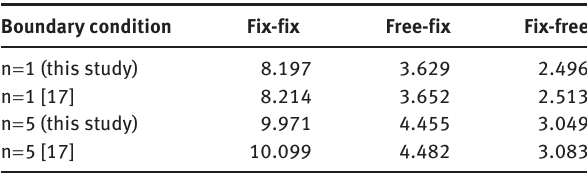
Table 1 Comparison study of the fundamental natural frequency of an isotropic FGM annular circular plate for different boundary condi- tions and power-law exponents (n = 1, 5).